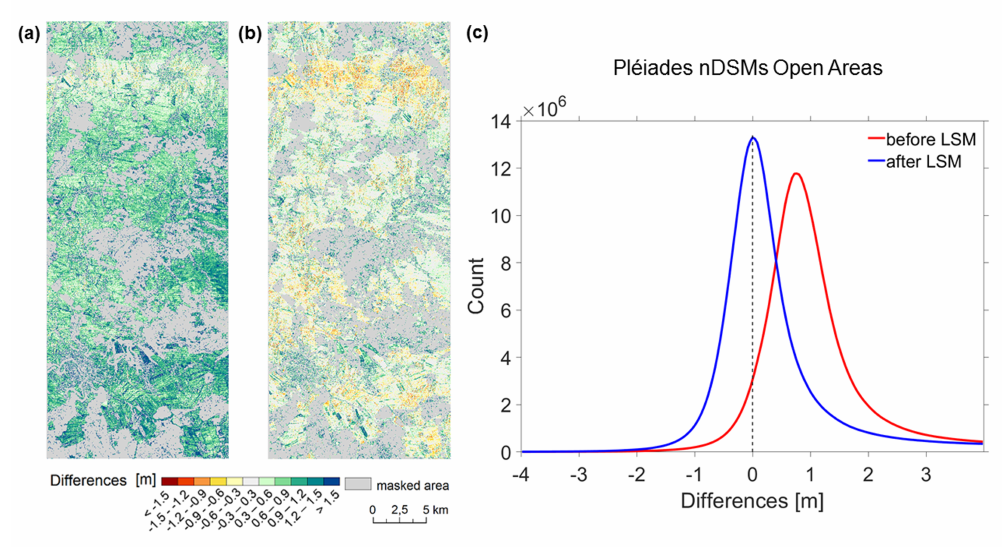
Figure A2. Pléiades nDSM statistics for open areas (masked areas are shown in grey): ( a ) spatial distribution of color-coded height differences before LSM; ( b ) spatial distribution of color-coded height differences after LSM; and ( c ) the frequency distribution histogram of Pléiades nDSM heights.